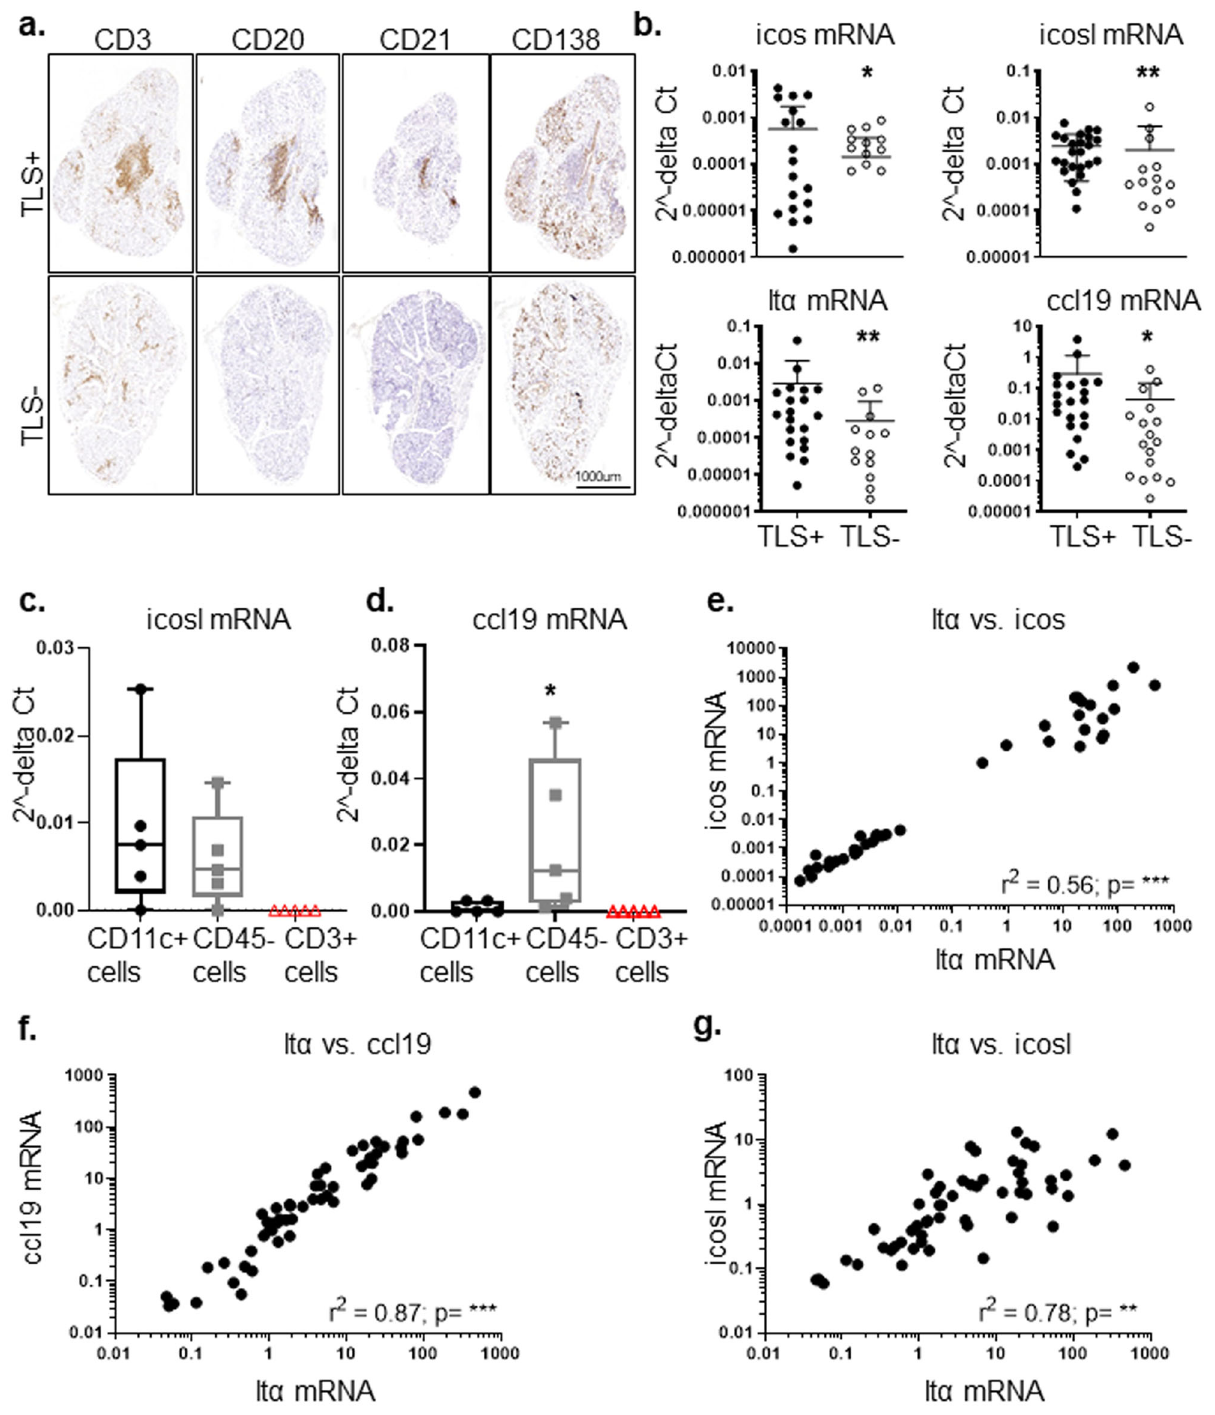
Fig. 4 Expression of ICOS and ICOSL in the salivary glands of patients with Sjögren ’ s syndrome. a Representative minor salivary glands (mSGs) sequential sections were stained for CD3 + for T cells, CD20 + for B cells and CD138 + for plasma cells for histological identi fi cation of tertiary lymphoid structures (TLS) in Sjögren ’ s syndrome salivary glands. b qPCR analysis for mRNA transcripts of icos, icosl, lt α and ccl19 in TLS + (black dots, n = 27) and TLS − (open dots, n = 29) mSGs biopsies from Sjögren ’ s patients. mRNA transcripts were normalized to the housekeeping gene 18 S RNA transcripts. * p < 0.05; ** p < 0.01, Mann – Whitney test. Data are representative as mean ± s.d. c , d Whisker plots showing icosl ( c ) and ccl19 ( d ) mRNA transcripts in dendritic cells (CD11c + ), non-hematopoietic (CD45 − ) cells and T (CD3 + ) cells were sorted from primary Sjögren ’ s patients ’ mSGs ( n = 5). Data are presented as min to max, * p < 0.05, Mann – Whitney test. e – g Linear regression analysis con fi rms signi fi cant correlation of lt α mRNA with icos mRNA ( e ), ccl19 mRNA ( f ) and icosl mRNA ( g ) in mSGs biopsies of Sjögren ’ s patients.